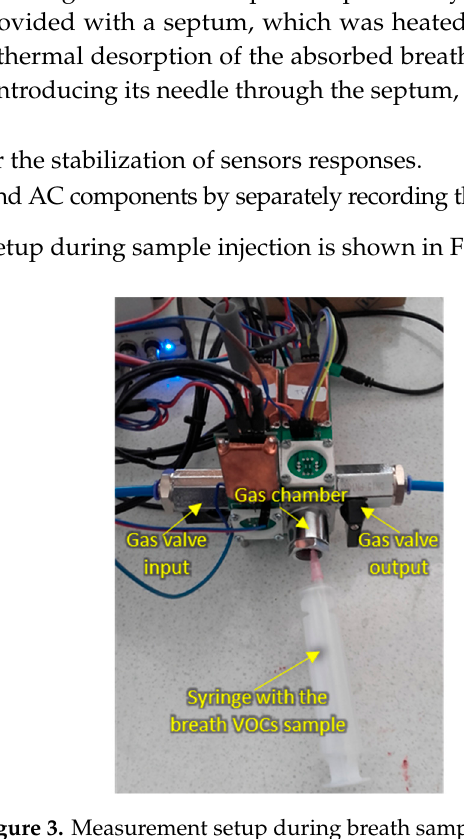
Figure 3. Measurement setup during breath sample injection.